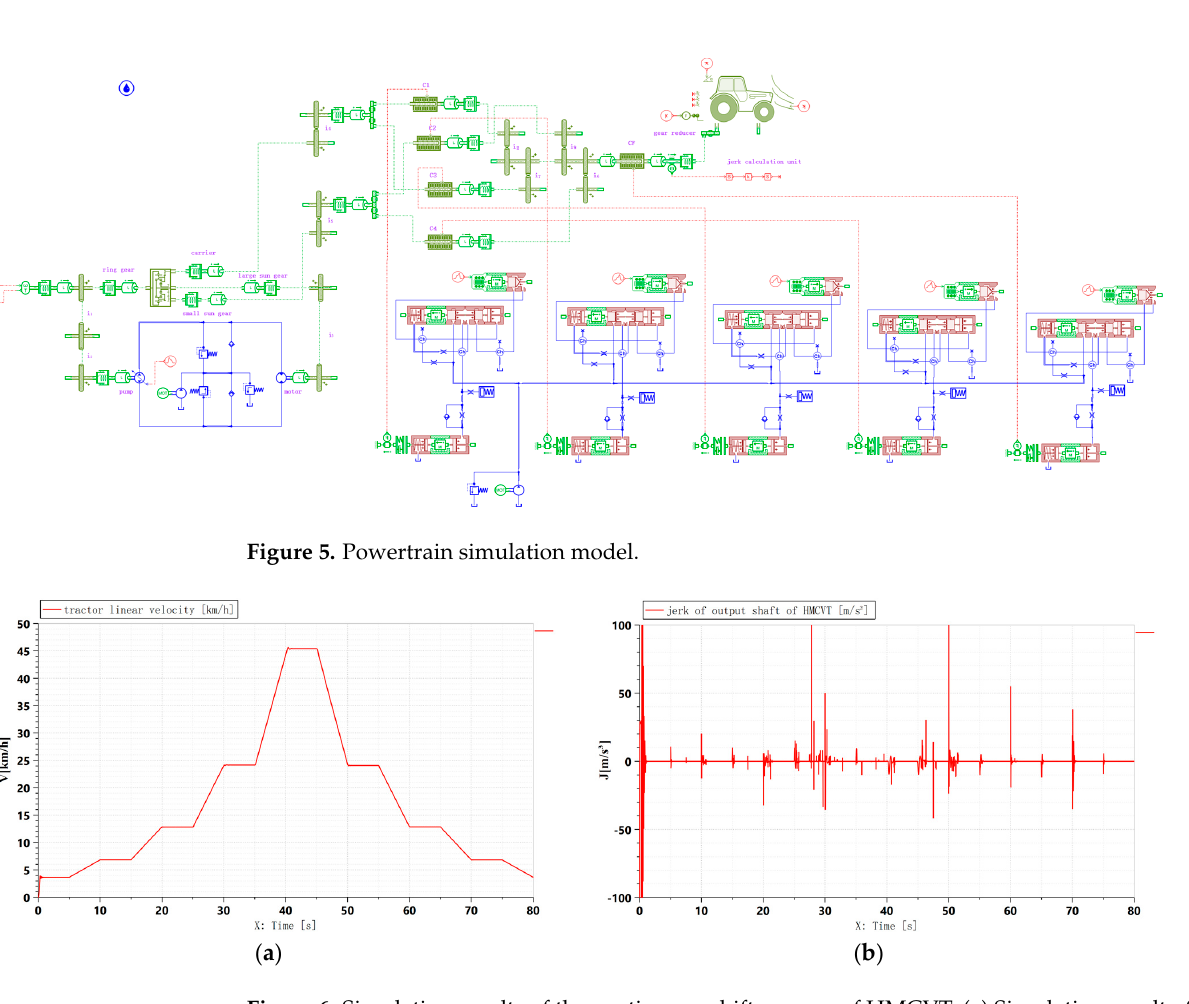
Figure 6. Simulation results of the continuous shift process of HMCVT. ( a ) Simulation result of the tractor linear velocity; ( b ) Simulation result of the jerk of the output shaft.